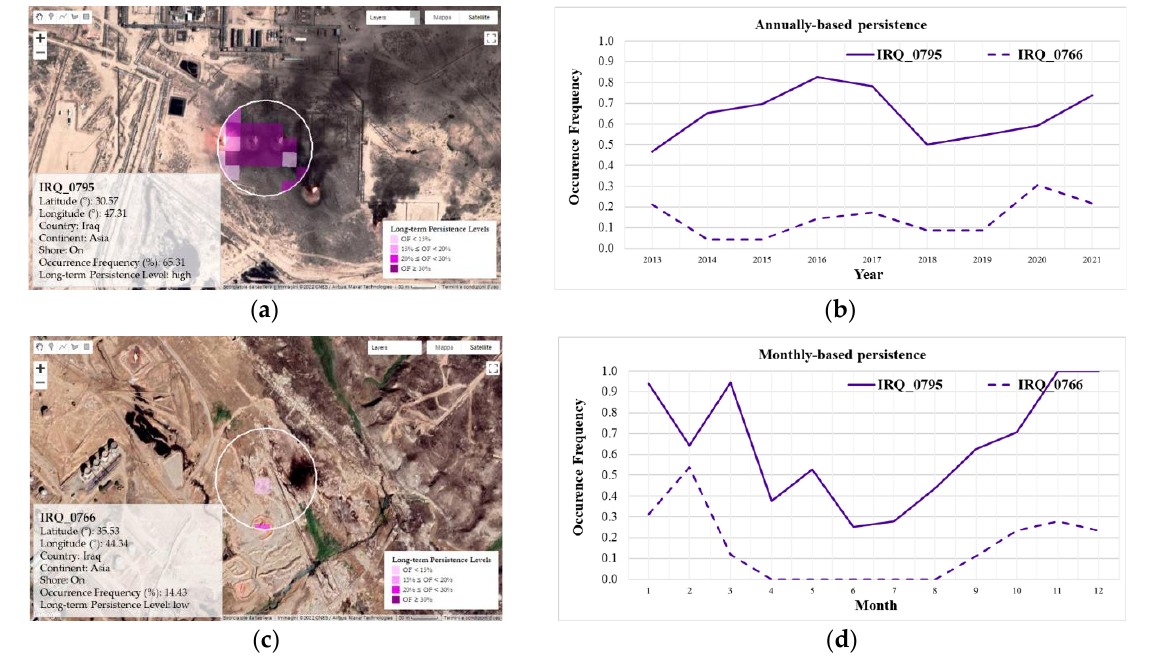
Figure 10. Features of the selected onshore GF sites, labeled as ( a ) IRQ_0795 and ( c ) IRQ_0766, retrieved from the DAFI GEE tool; the insets summarize the GF geographic information, along with its long-term persistence category. The ( b ) annual and ( d ) monthly temporal persistence for IRQ_0795 (purple line) and IRQ_0766 (purple dashed line).